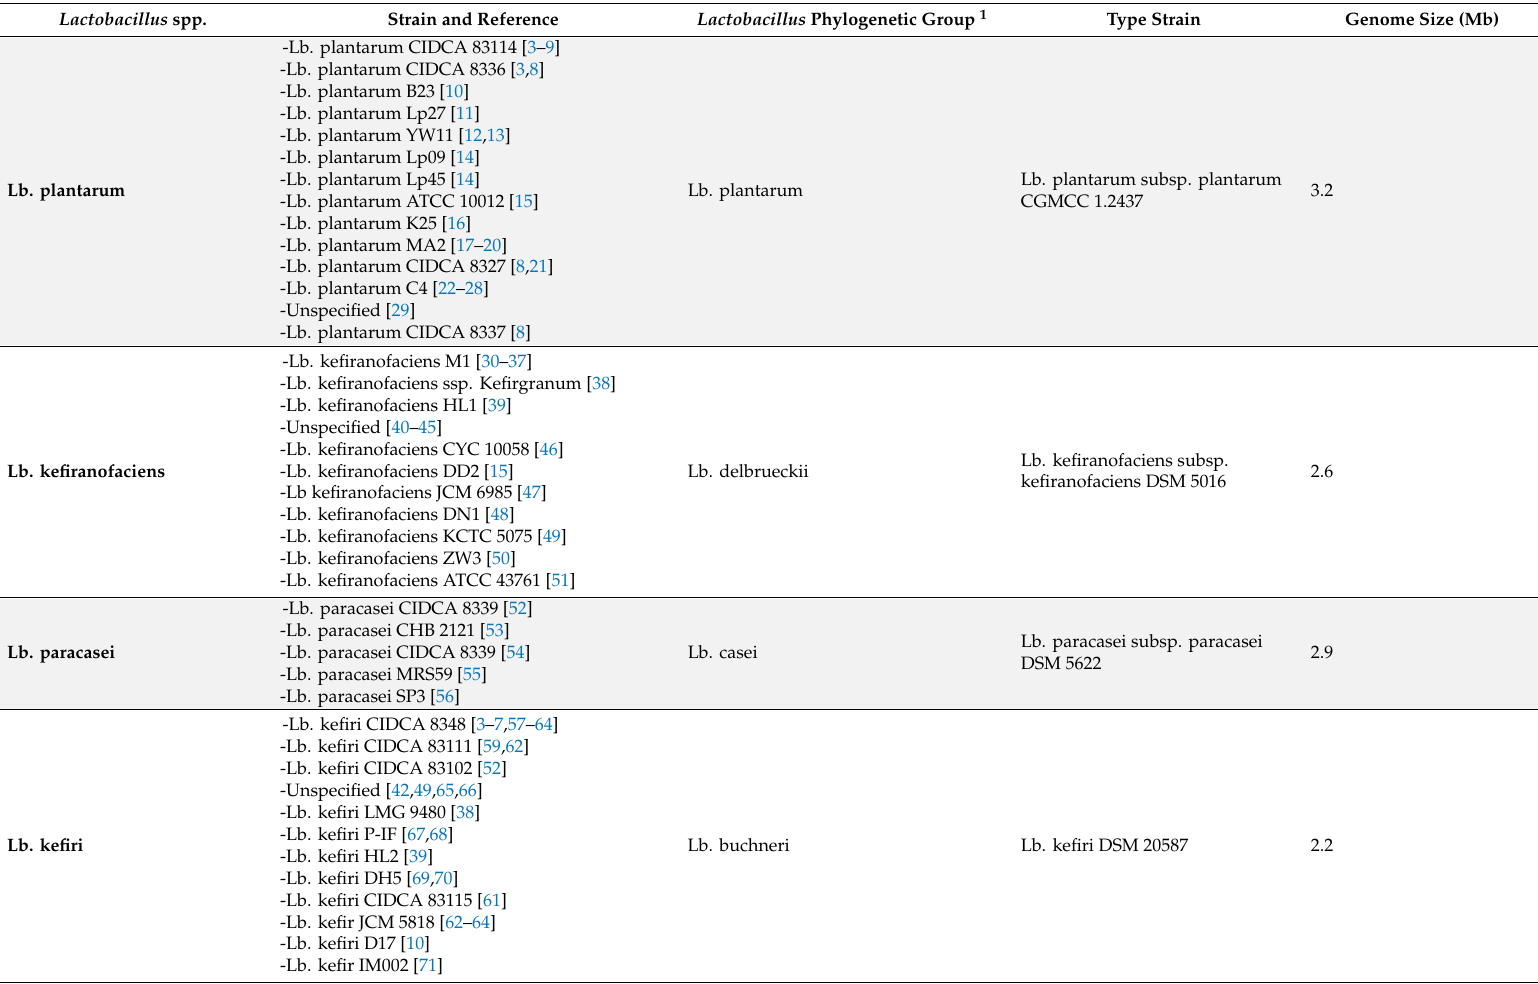
Table 1. List of Lactobacillus species and strains found in milk